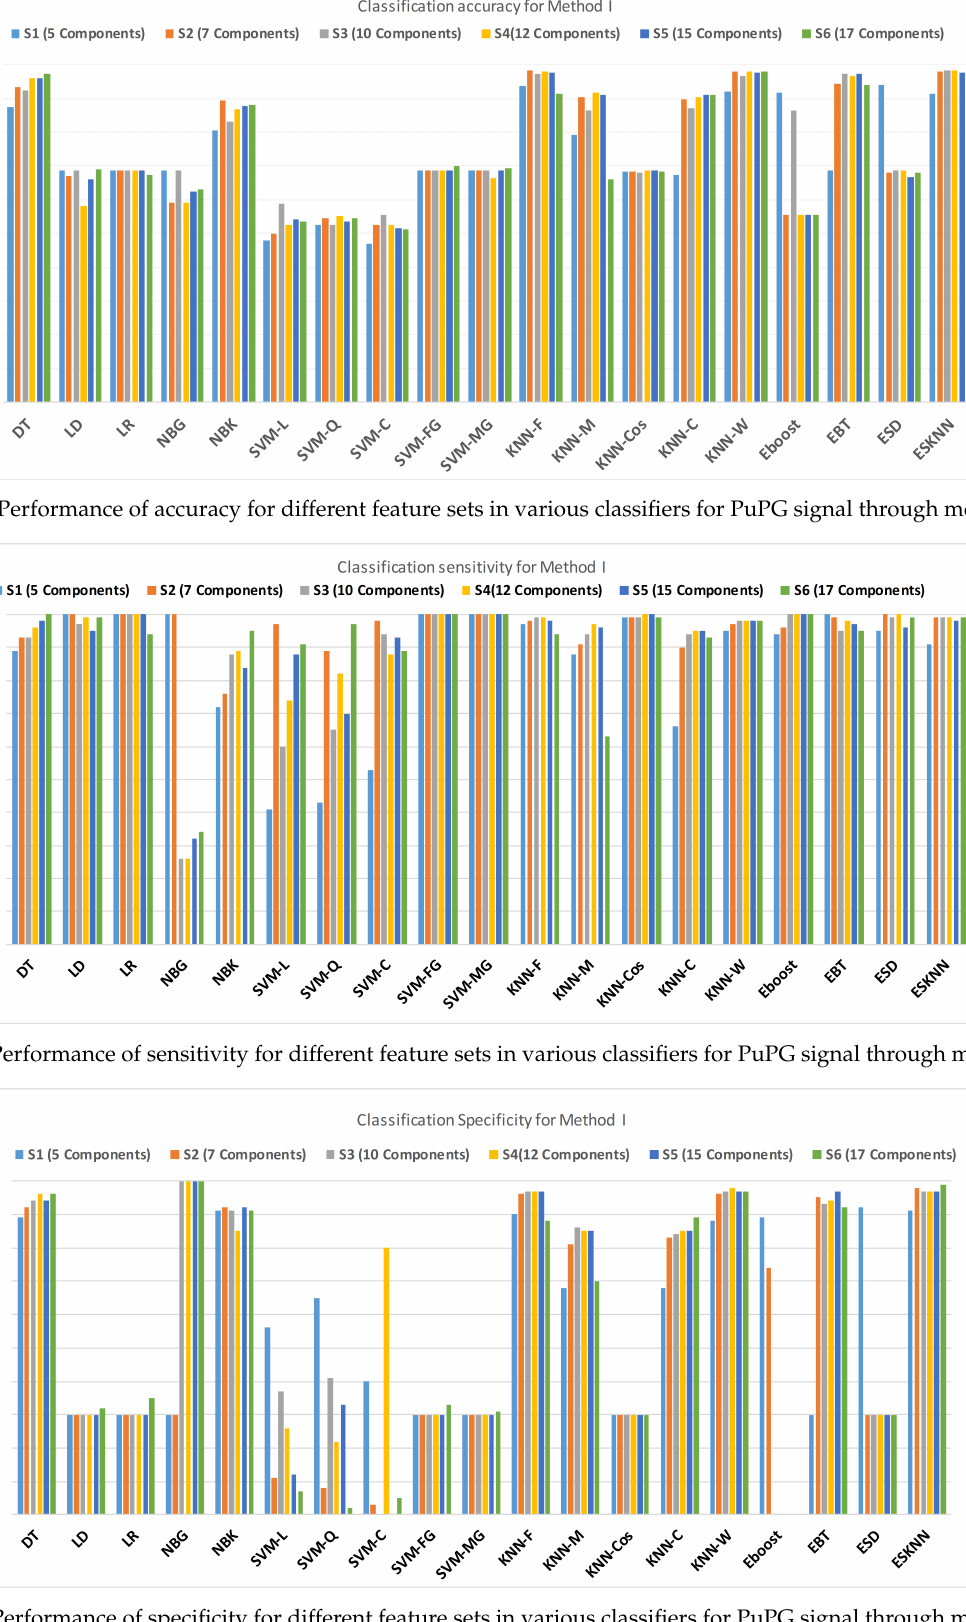
Figure 13. Performance of specificity for different feature sets in various classifiers for PuPG signal through method